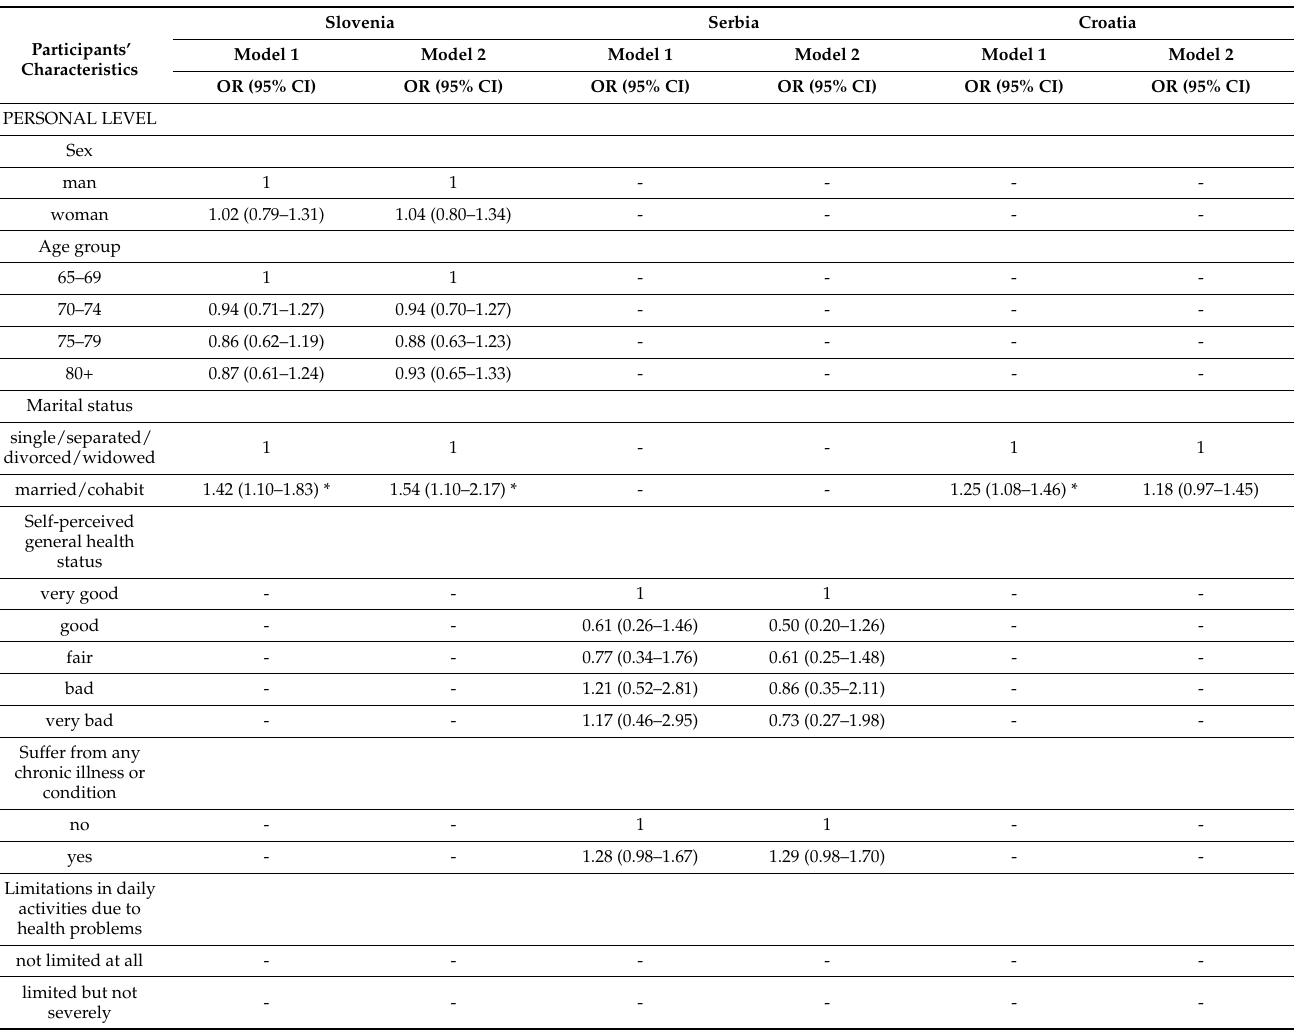
Table 7. Multivariate logistic regression models for the financial burden of dental